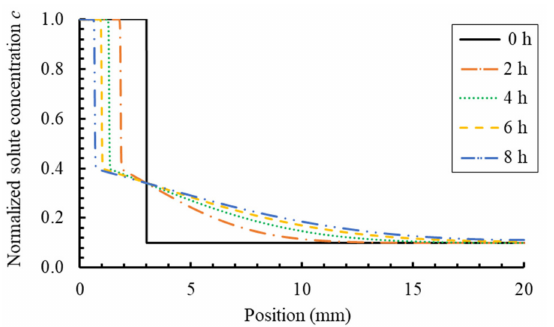
Figure 5. One-dimensional distribution of solute concentration by PF model ( L = 4.02 × 10 − 1 ).